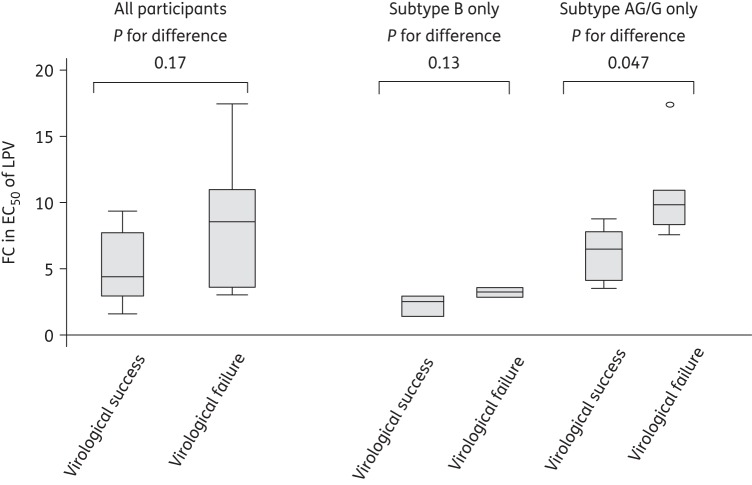
Box plots of phenotypic assay FC in EC50 of lopinavir (LPV) by treatment outcome.